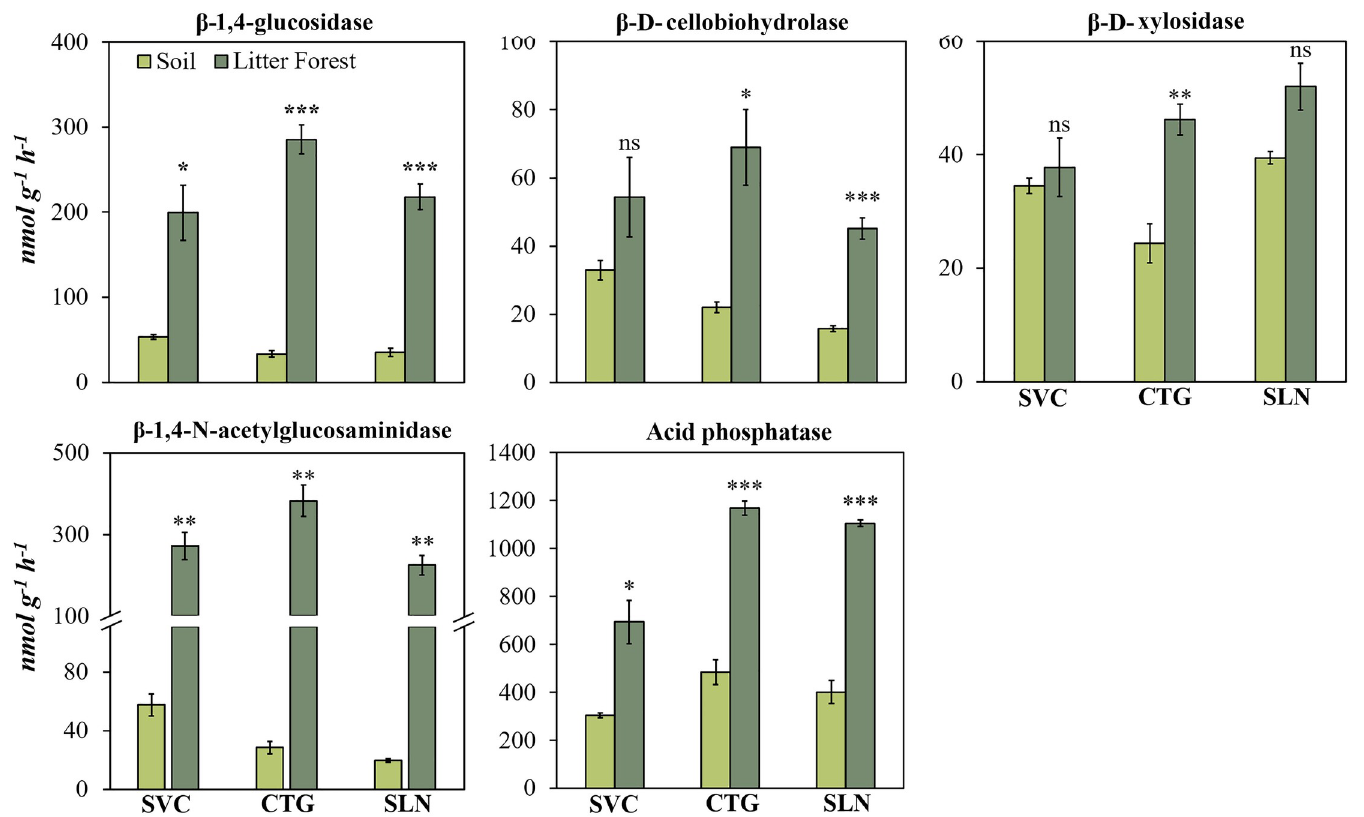
Fig 2. β -1,4-glucosidase, β -D-cellobiohydrolase, β -D-xylosidase, β -1,4-N-acetylglucosaminidase, acid phosphatase enzymes activity in soil and litter of the forest located in hill landscape sites (SVC: San Vicente del Caguan, CTG: Cartagena del Chaira, SLN: Solano) of Colombian Amazon region. Error bars denote standard error. Asterisks indicate that the means values differ significantly between themselves to the level p < 0.05 ( � ), p < 0.01 ( �� ) and p < 0.001( ��� ) for each study site, according to the Student’s Test.